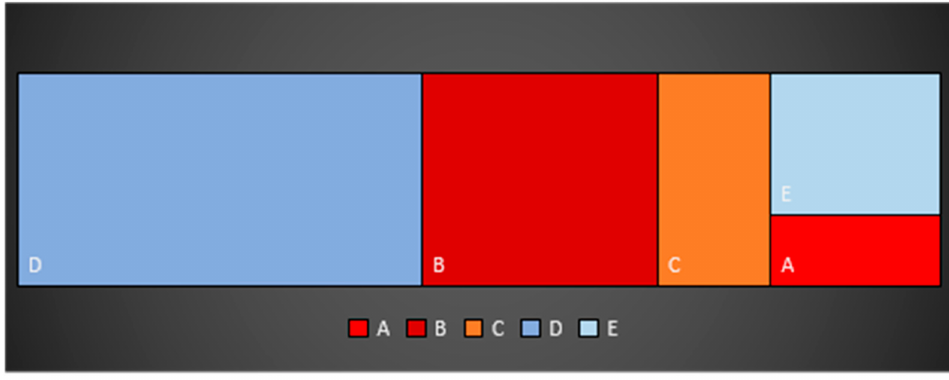
Figure 2. Visual representation of priority sources in